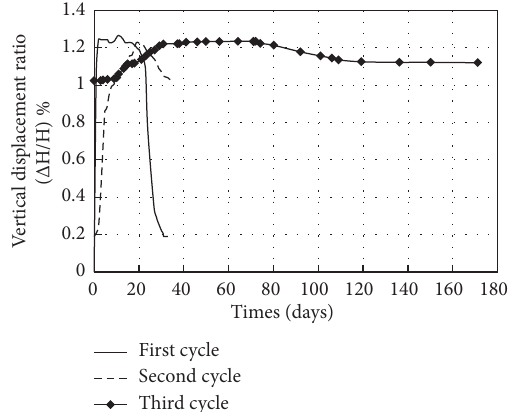
Figure 10: Vertical displacement ratio versus time for each cycle for TECS.